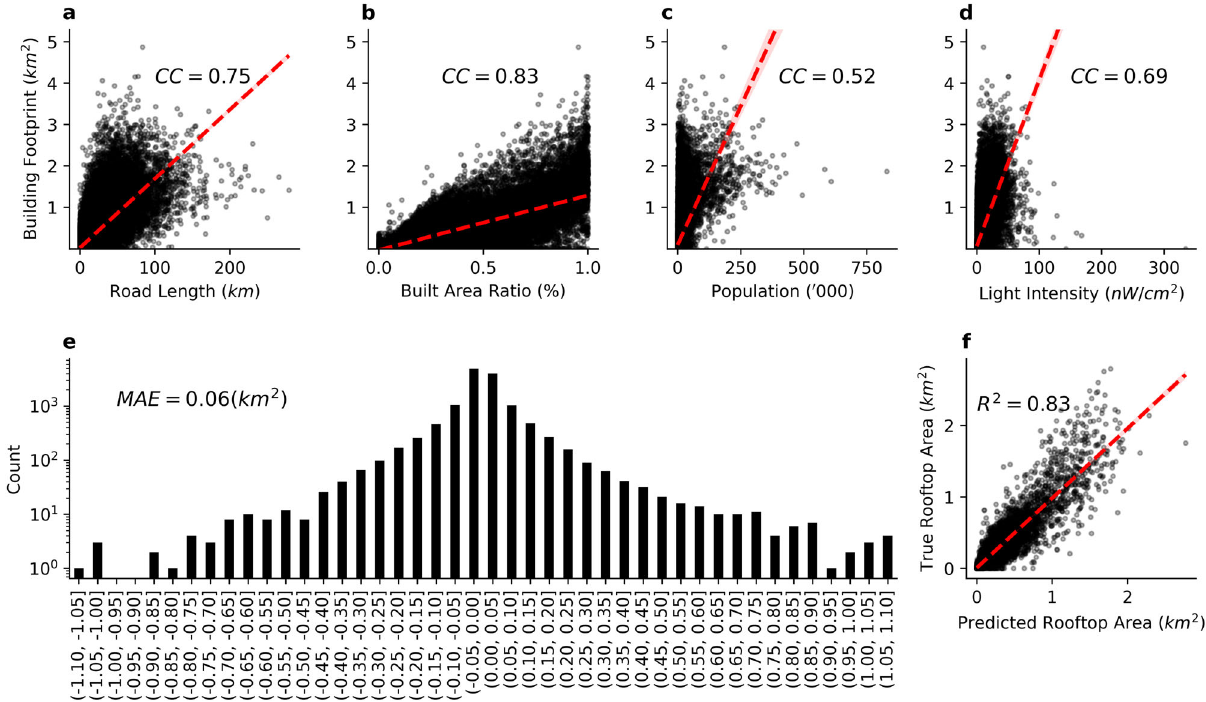
Fig. 3 | Relationship between inputs, distribution of errors, and performance of the extrapolation model. a Road length, b proportion of built-up area, c population size, and d nighttime light intensity relative to the rooftop area. The Pearson correlation coef fi cients (CC) for these distributions are 0.75, 0.83, 0.52, and 0.69, respectively (signi fi cant at the 0.0001 level). e When the trained